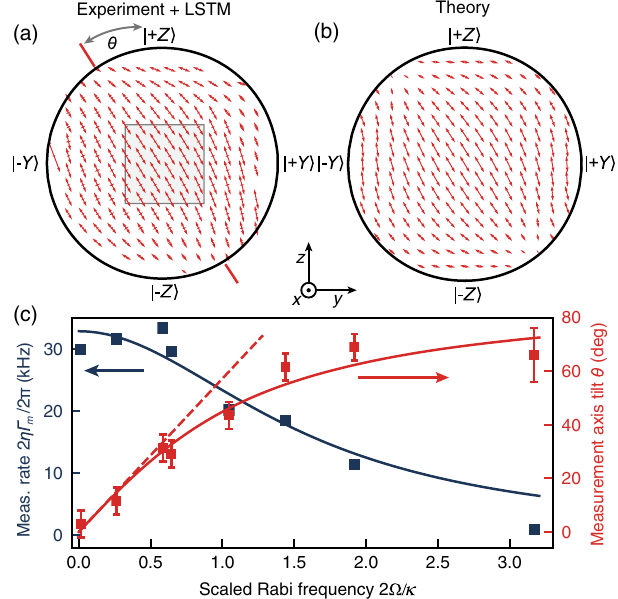
FIG. 4. Resonator memory corrections to the measurement backaction from LSTM trajectories. (a) Trajectory diffusion map for 2 Ω = κ ¼ 0 . 6 , obtained by computing the eigenvectors of the covariance matrix Eq. (2) for trajectories binned in the yz plane. See also Figs. 3(a) and 3(b). The tilt toward j (cid:2) Y i in the plane of the Rabi drive is in contrast to the prediction from Eq. (8) and (9). (b) The theory prediction, detailed in Appendix L, includes resonator memory effects and reproduces the tilt. (c) For small Ω = κ the measurement axis tilts linearly with the Rabi frequency θ ¼ 2 Ω = κ (dashed line). The experimental tilt of the measure- ment eigenstates in the yz plane (red squares) is accompanied by a decrease in measurement rate (blue squares). Solid lines are fits to Eq. (11) (red) and Eq. (12) (blue), respectively. The error bars for θ are estimated from the imprecision in determining the tilt angle. The error bars for the measurement rate obtained from fitting are smaller than the